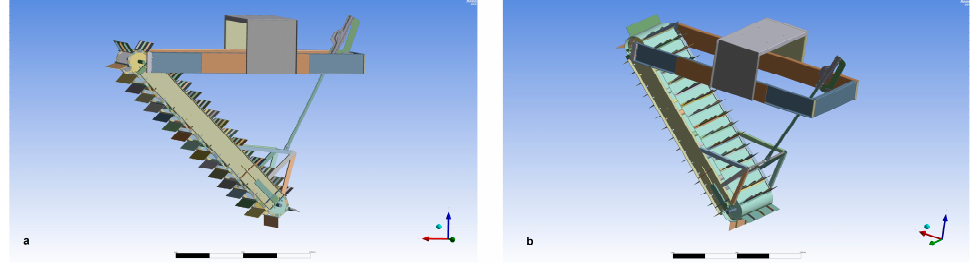
Figure 1. ( a ) Open-Chain ECB with 35 blades; ( b ) Closed-Band ECB with 35 blades.